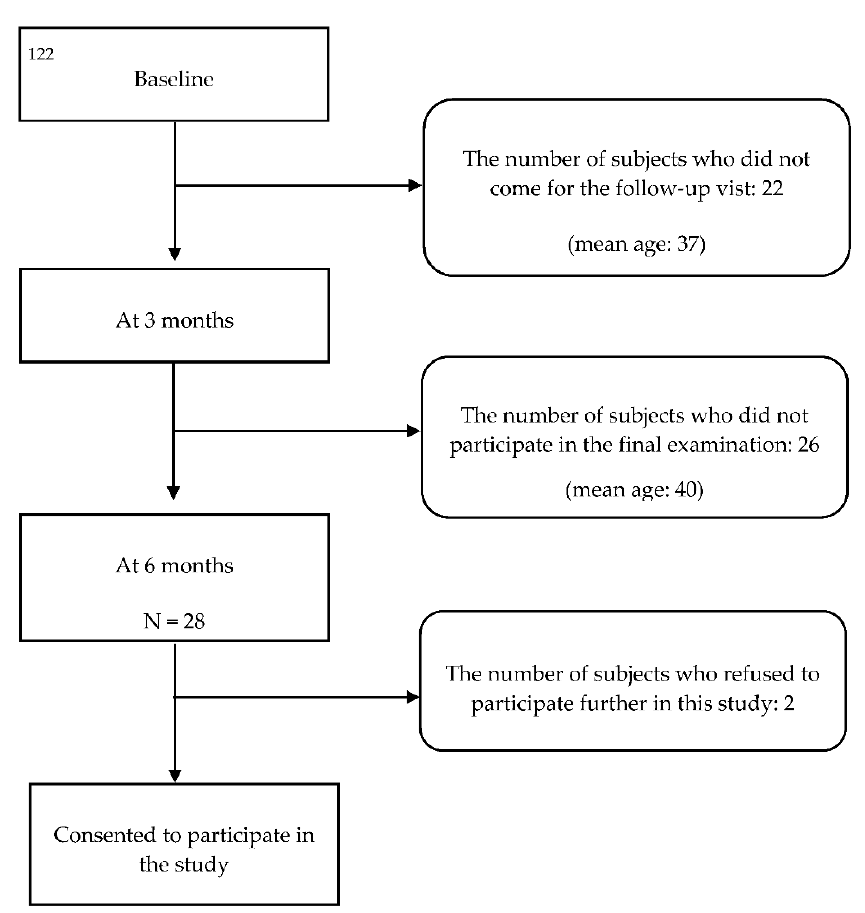
Figure 1. Flow chart describing the number of participants at each study stage.